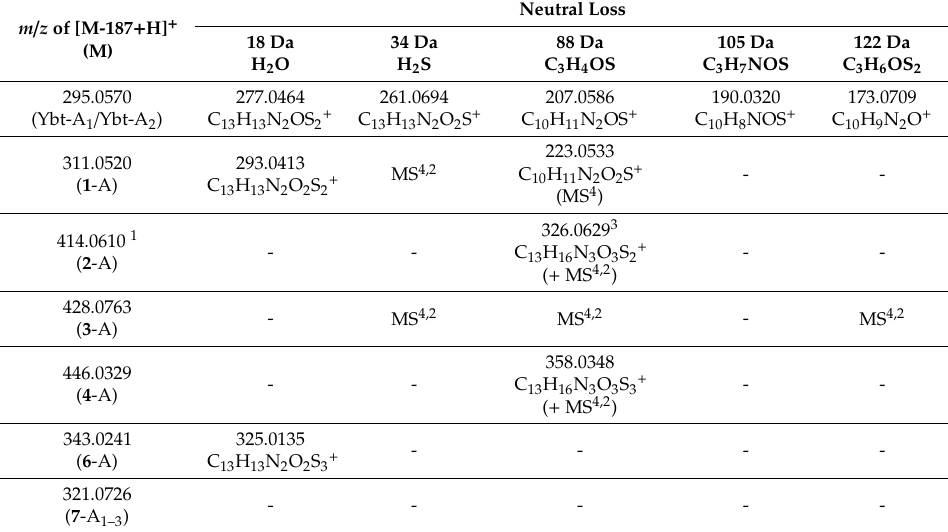
Table5. SelectedNLsrecordedduringMS 3 experimentsofYbtanditsnovelderivativesbyapplicationof LC-HRMS. All recorded fragmentation spectra are shown in the Supplementary Material. The resulting fragments [M-187-X + H] + caused by the specific NL [X] listed on top of the columns are noted in the table. The most intense ion was used for MS 4 experiments. m / z of [M-187 + H] +